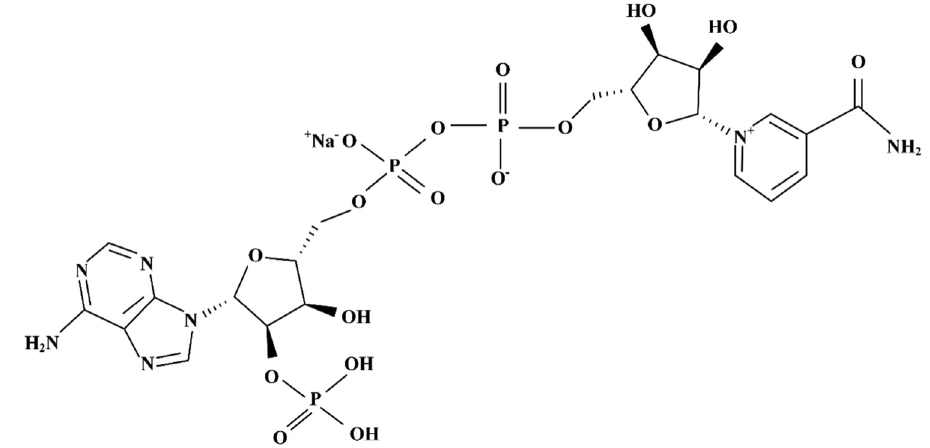
Figure 7: The structure of nicotinamide adenine dinucleotide.